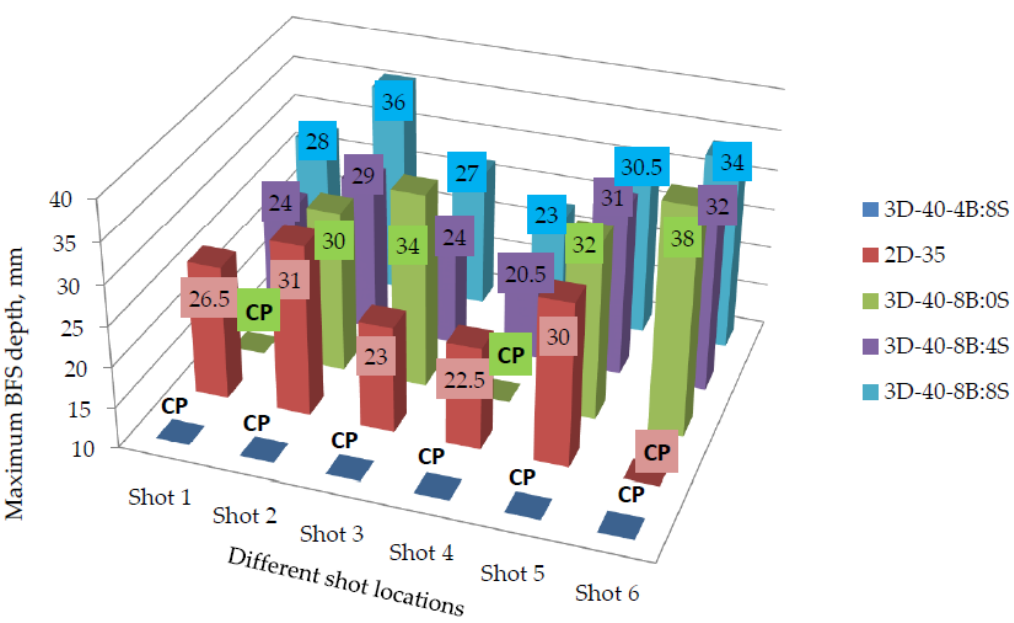
Figure10. MaximumBFSdepthfordi ff erent3Dwarpinterlockvariantsand2Dplainweavepara-aramid Figure 10. Maximum BFS depth for different 3D warp interlock variants and 2D plain weave para- fabrics at di ff erent shoot locations (*CP—represents the complete penetrated panel at the specified aramid fabrics at different shoot locations (*CP—represents the complete penetrated panel at the shot specified shot point).